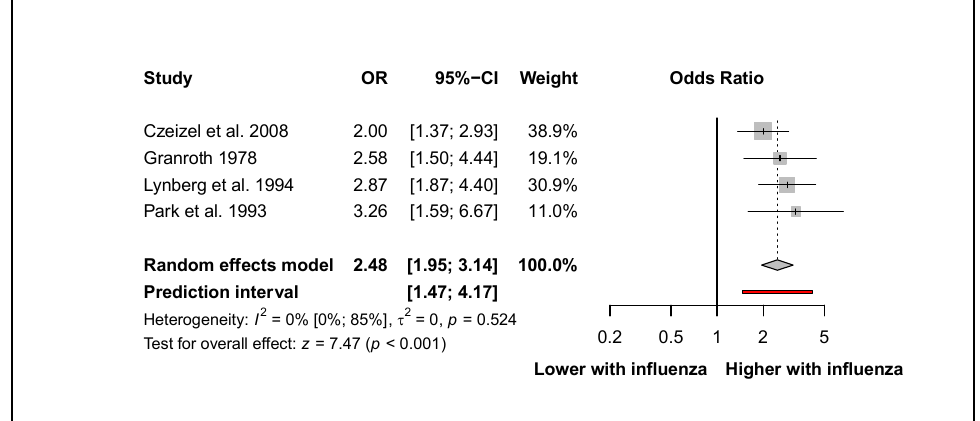
Figure 2. The odds of developing neural tube defects after influenza infection in the first trimester [34–36,38]. Pooled results from three articles [34–36] showed that influenza was associated with more than two times increased odds for the development of spina bifida (OR: 2.22, CI: